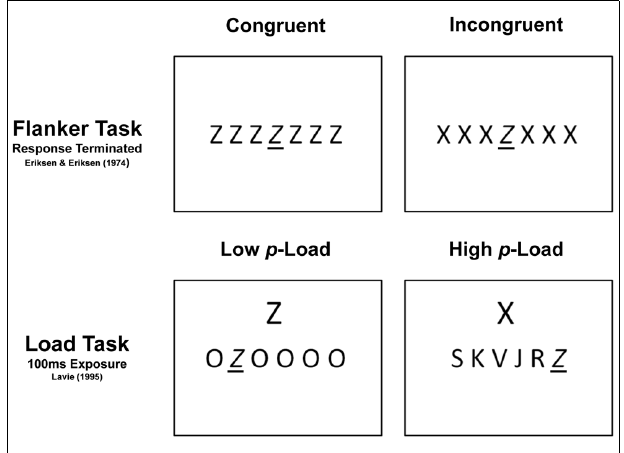
FIGURE 1 | Canonical Flanker and load tasks. The Eriksen Flanker task, top two panels, has both congruent and incongruent conditions. In the Eriksen Flanker task, the target is always located in the center. In the load task, lower two panels, the Flanker is either above or below the stimulus array and the relevant load is determined by the relationship between the distractors in the linear array and the target; additionally, the target can appear at any one of the six linear locations.The targets in these examples (all the letter “Z”) have been italicized and underlined for distinction. Whereas the Flanker task employs response terminated displays, the load task uses brief